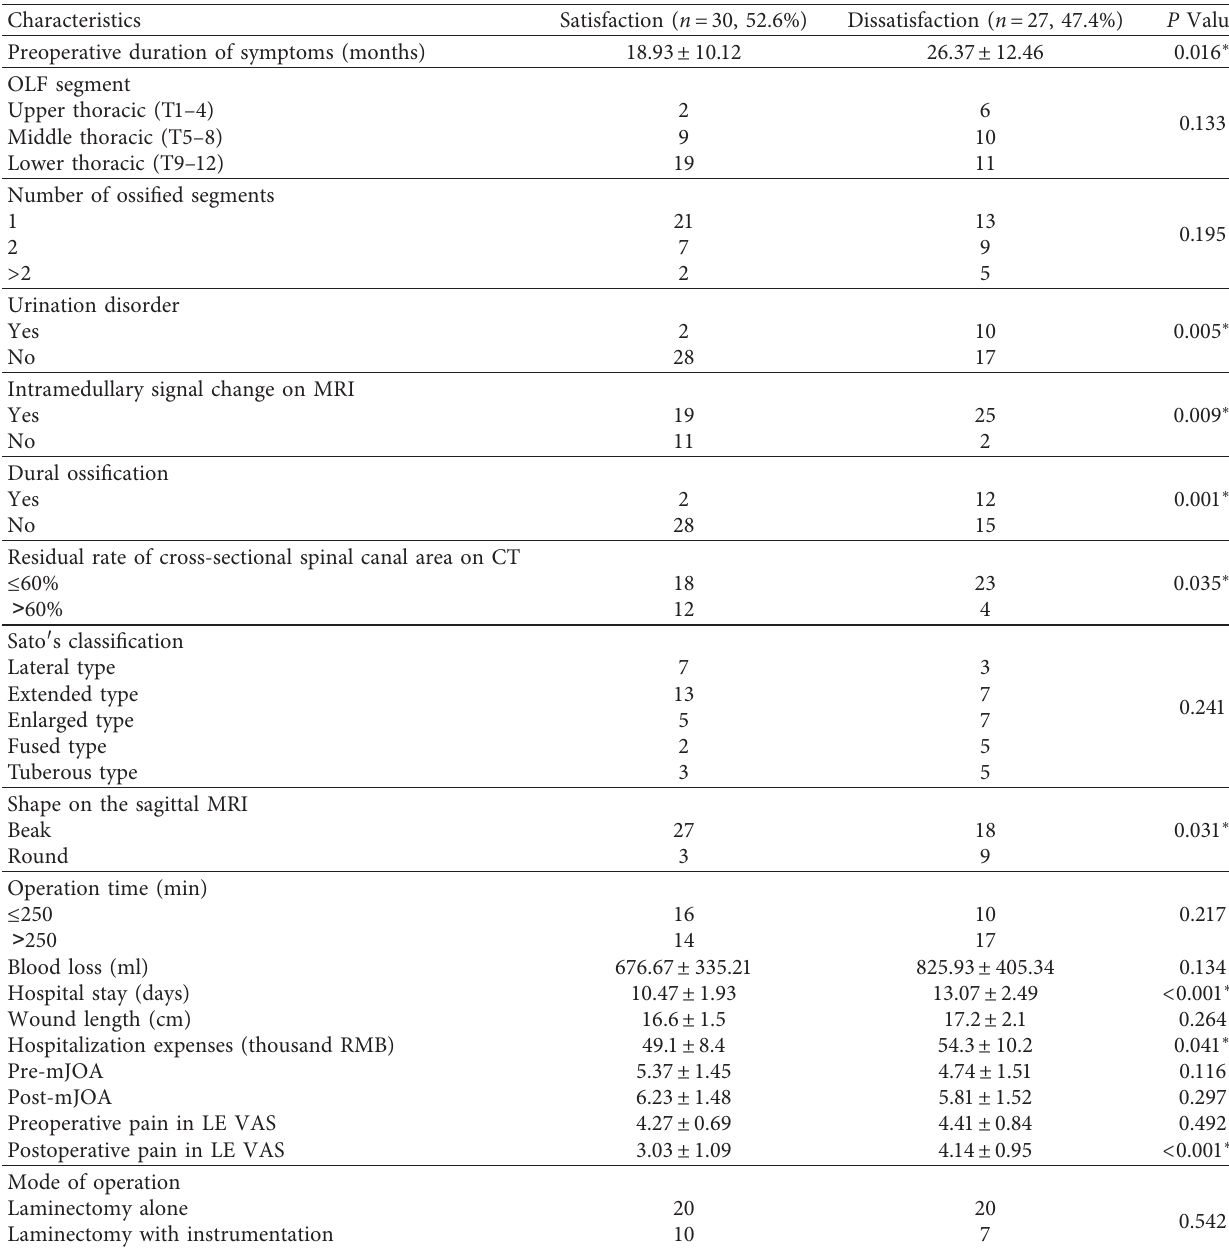
Table 4: The related risk factors of satisfied and dissatisfied patients at discharge.